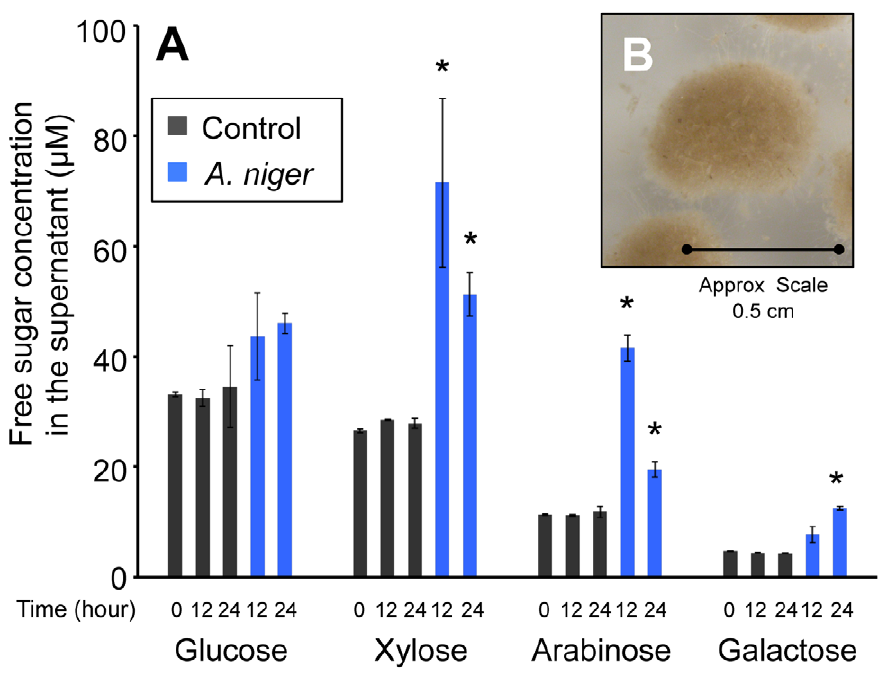
Figure 1. Free sugars in the straw media. (A) The monomeric sugar content of culture supernatants was analysed by HPLC at 0, 12 and 24 h after the transfer of the mycelia to the straw media. Each bar represents the mean + / 2 the standard deviation of values from three independent experiments where black represents control cultures and blue represents cultures containing A. niger . The asterisk indicates p-values , 0.05 relative to the control culture at the corresponding time by unpaired t-test. (B) A. niger mycelial clump from a culture grown for 24 hours in minimum media containing straw as sole carbon source.